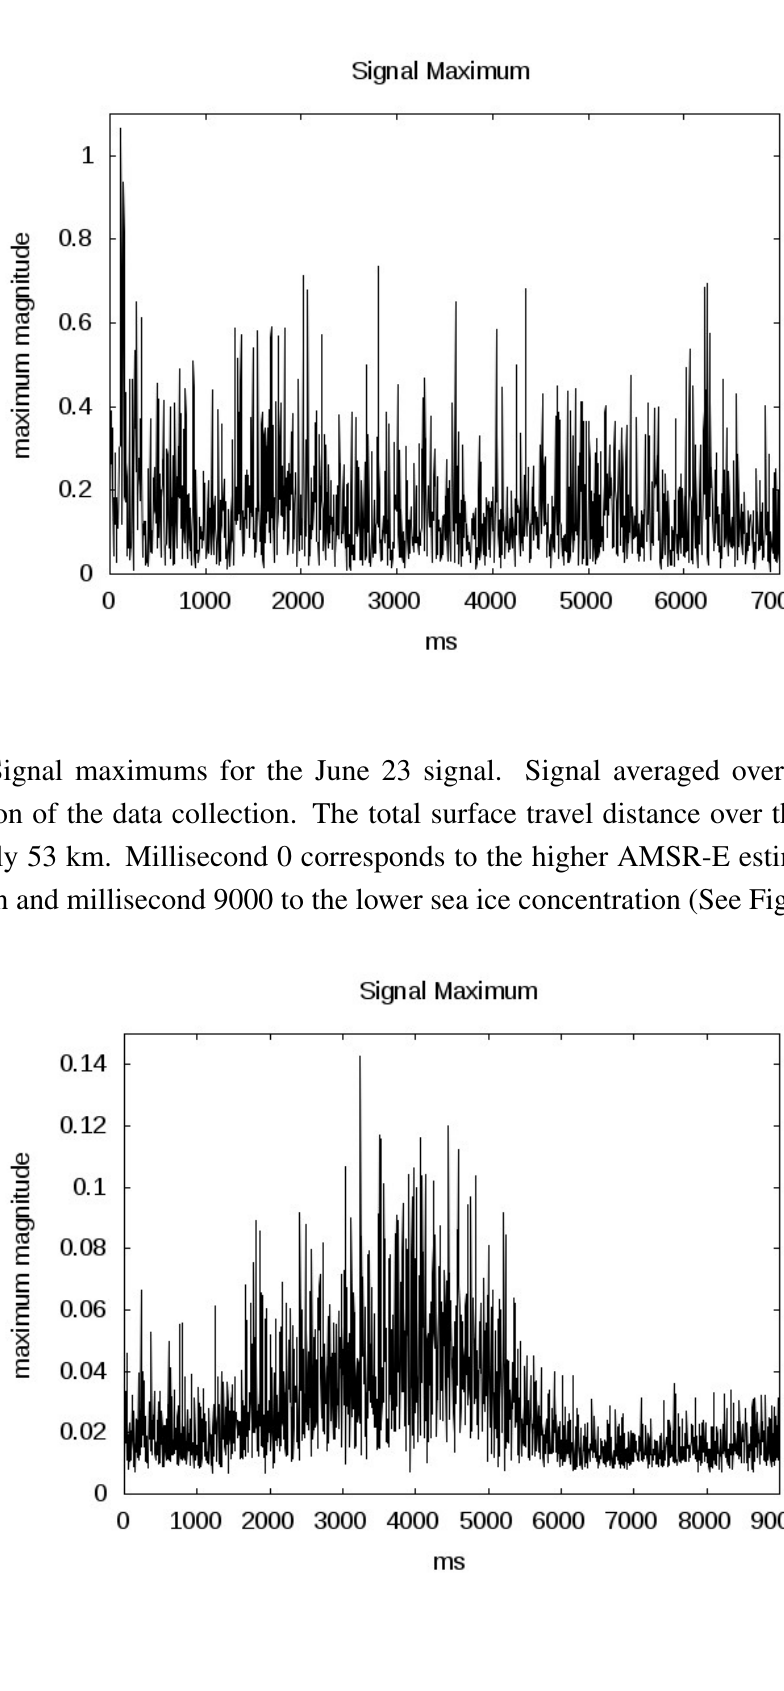
Figure 7. Signal maximums for the February 4th signal. Signal averaged over 5 ms across entire duration of the data collection. The total surface travel distance over this interval is approximately 42 km.